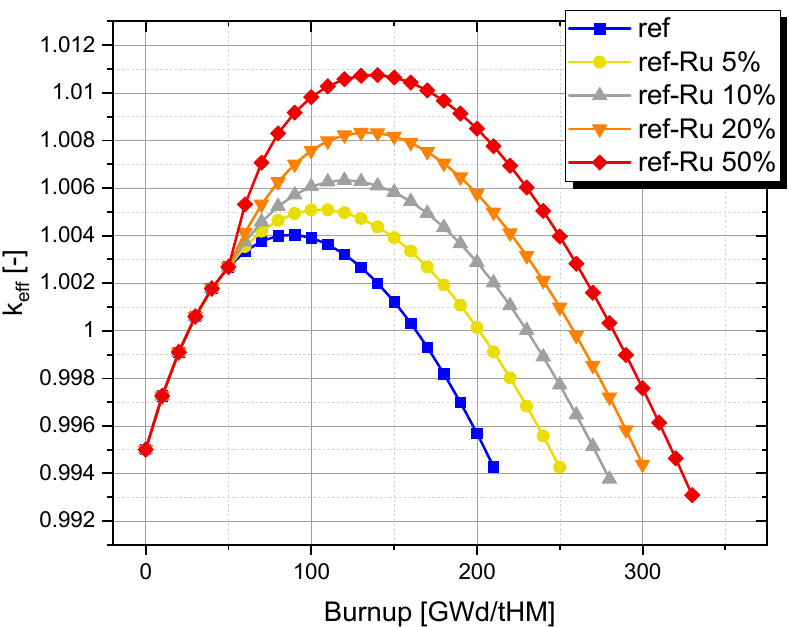
Figure 7. Effect on criticality caused by different reduction efficiencies of the clean-up on the example of Ruthenium separation, based on a simulation using 10 GWd/tHM steps and an initiation of the clean-up system after 50 GWd/tHM.